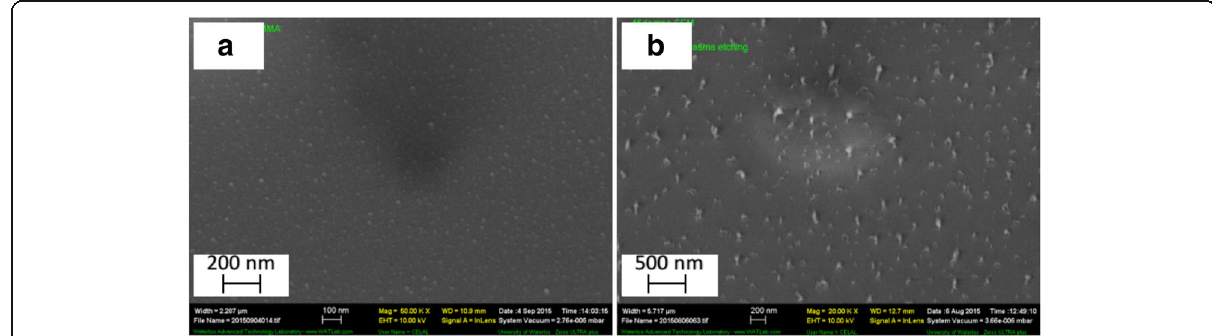
Fig. 2 SEM image leftovers of PMMA film on silicon substrate upon oxygen plasma treatment. a Result of oxygen plasma process on pure PMMA film and b metal salt-containing PMMA film after 10-min oxygen plasma